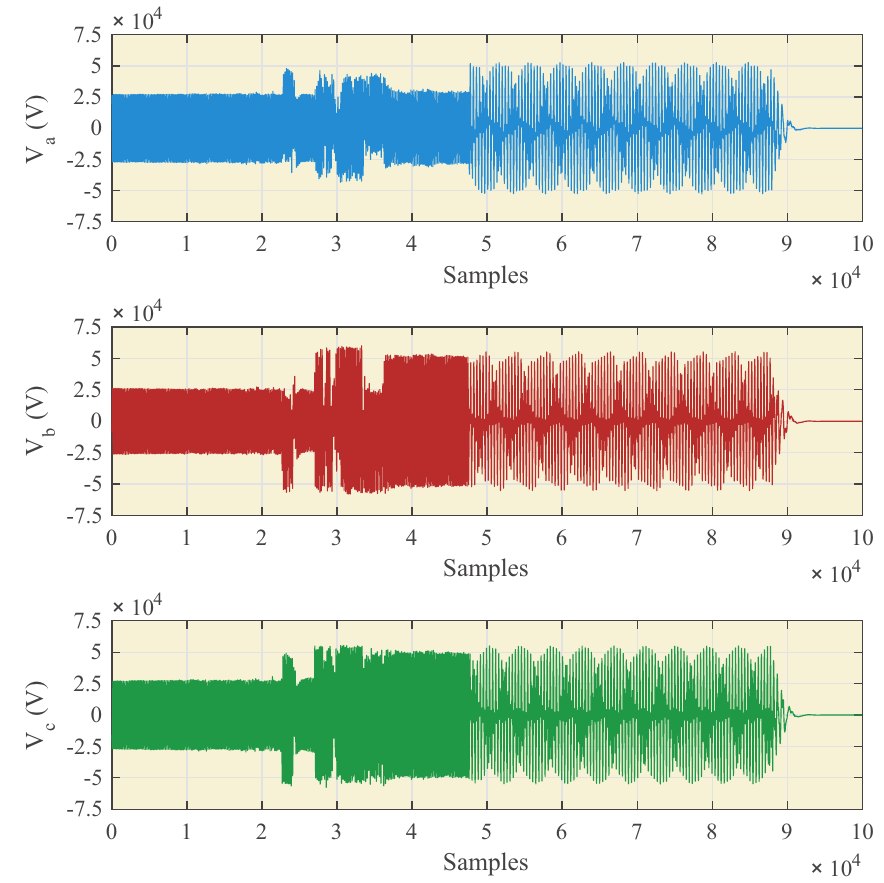
Figure 5. Line-to-earth fault and ferroresonance event. Time-domain phase